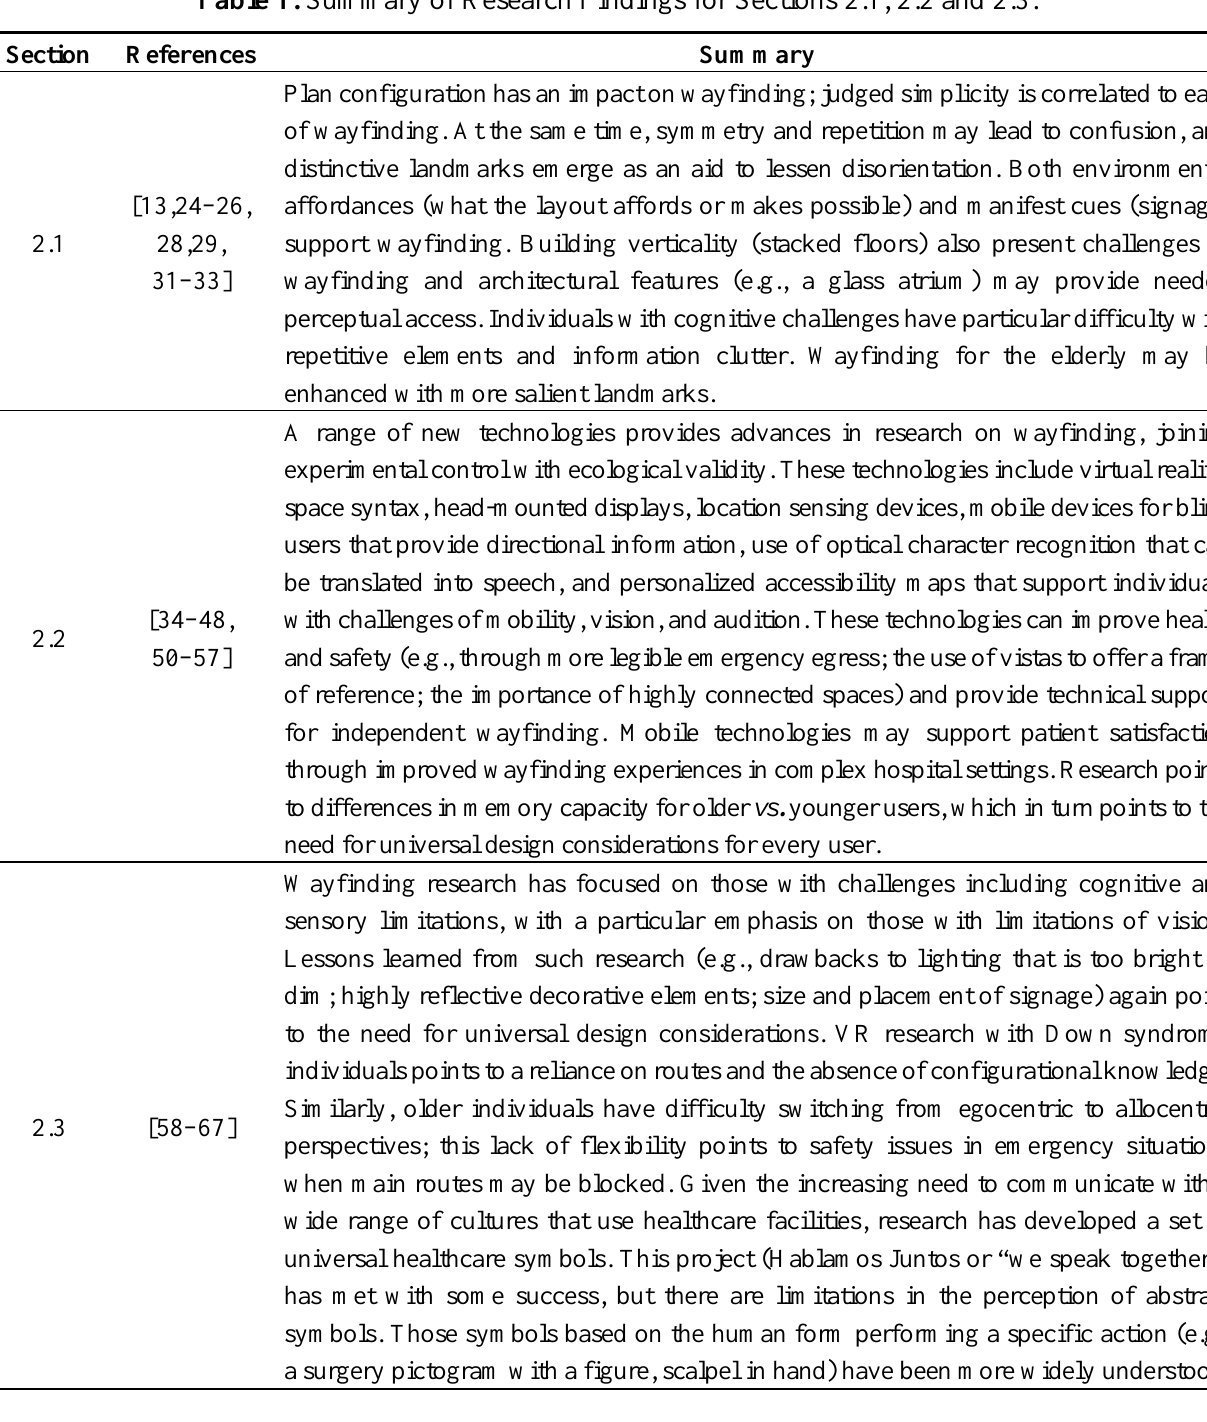
Table 1. Summary of Research Findings for Sections 2.1, 2.2 and